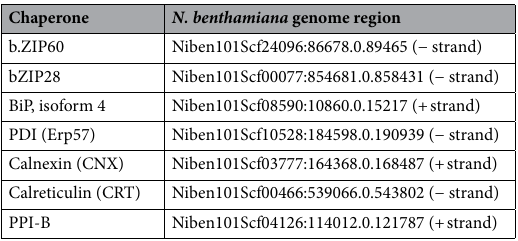
Table 1. Genome location of Nicotiana benthamiana master regulators and